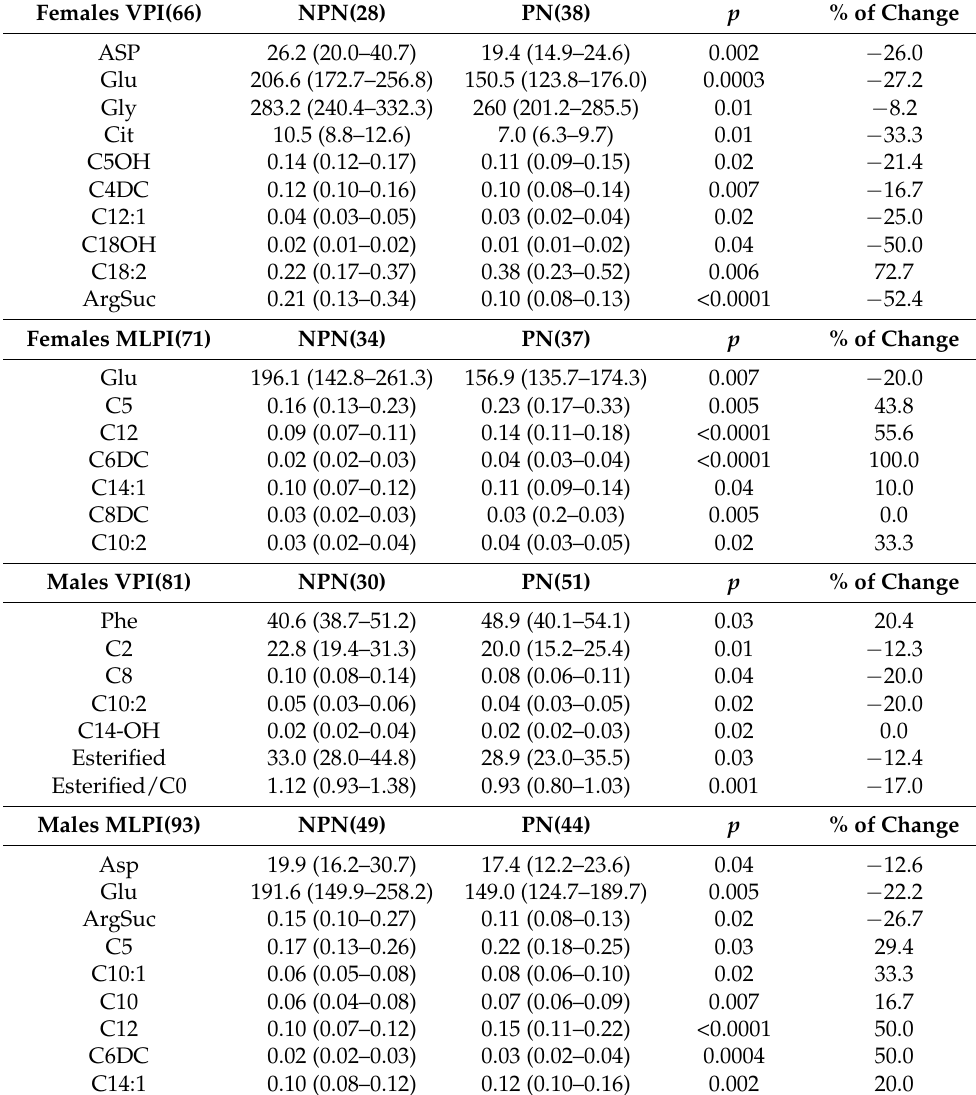
Table 3. Intra-sex analysis of PN effect in females and